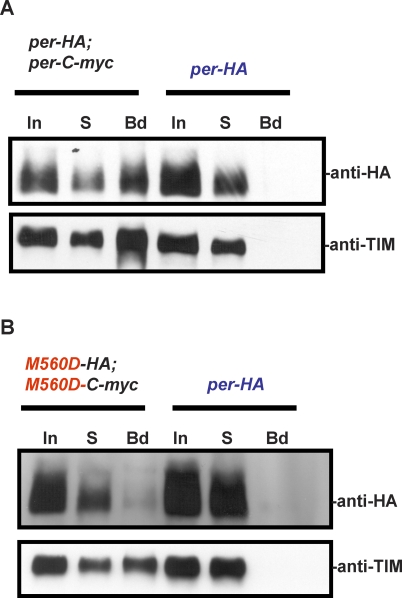
Formation of PER:PER Dimers Is Disrupted by the M560D MutantCoIP experiments with flies containing double-homozygous wild-type PER (A) or M560D PER (B) encoding transgenes fused to HA and c-myc tags (lanes 1–3), or homozygous transgenes fused to HA (lanes 4–6). CoIPs were performed with flies collected at ZT20 as described in Materials and Methods. Western blots were incubated with anti-HA and anti-TIM antibodies as indicated. Protein extracts of flies expressing both an HA and c-myc (lane 1), or only the HA tagged version of PER (lane 4) were loaded as Input control (In). In lanes 3 and 6, proteins eluted from anti-c-MYC coated beads are loaded (Bd) for double tagged, and singly HA tagged flies. Lanes 2 and 5, Supernatant (S) after binding the extracts to anti-MYC coated beads. The strong anti-HA signal in lane 3 (upper panel) clearly indicates binding of HA-tagged PER to MYC-tagged PER (i.e., homodimer formation), whereas the weak signal in the lower panel of lane 3 indicates severe disruption of homodimer formation. The lack of signal in lane 6 indicates that HA-tagged proteins do not bind unspecifically to anti-MYC beads. Note that both wild-type and M560D mutant proteins bind to TIM (lane 3, upper and lower panels). This experiment was repeated three times with similar results, except that the anti-HA signal of M560D flies was completely absent in the “Beads” fraction in the other two trials (see also Figure 5A).